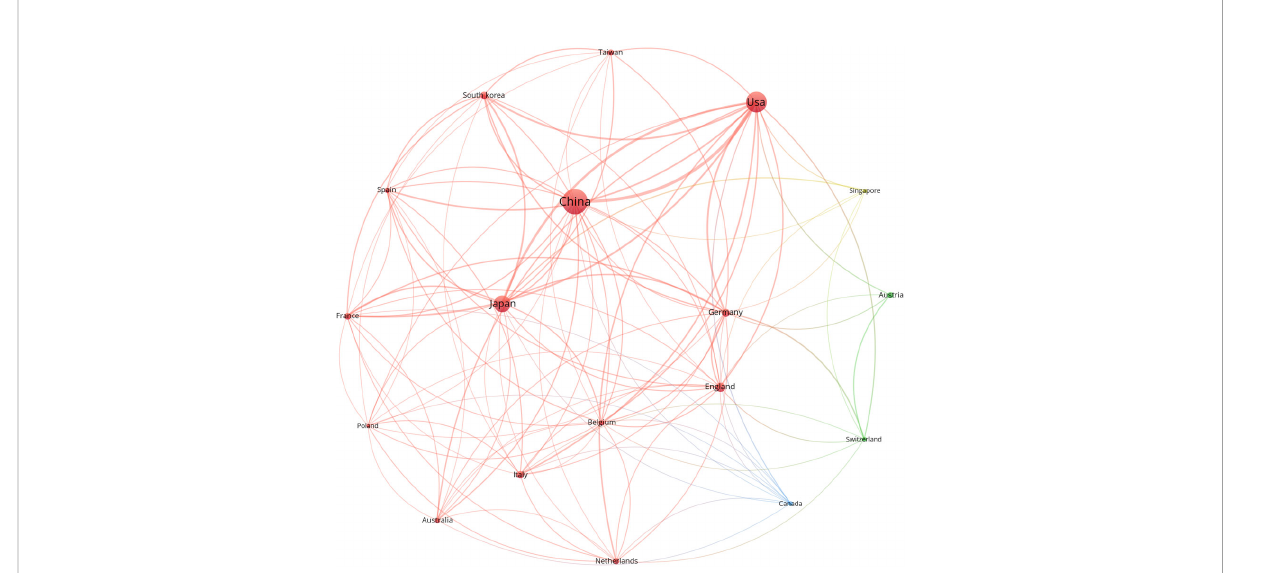
FIGURE 3 The co-authorship network visualization map of countries/regions. Larger nodes represent more publications of the term. Lines between nodes represent the connection between